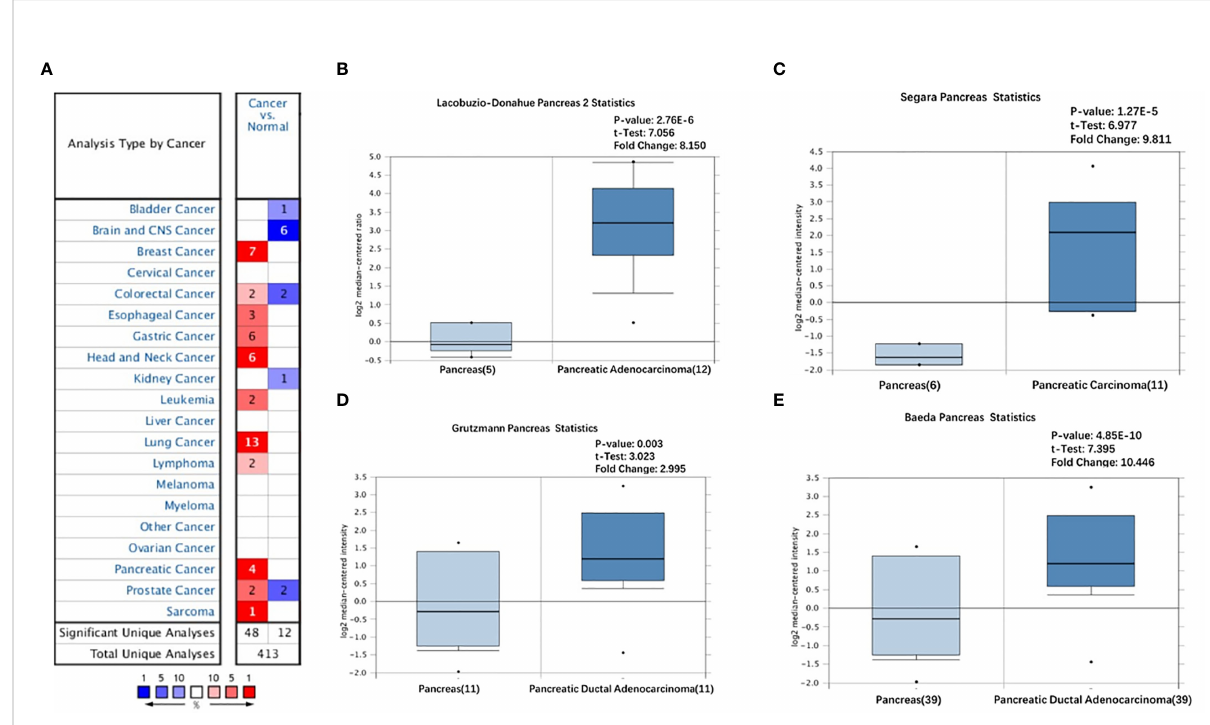
FIGURE 2 Overexpression of GREM1 in PDAC based on Oncomine database. (A) Different expression of GREM1 in multiple tumors (fold change > 2, p - value < 0.05). (B – E) The increase of GREM1 mRNA in four studies. PDAC, pancreatic ductal